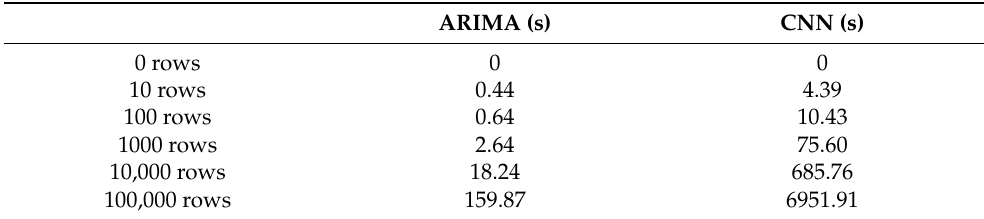
Table 8. Computational speed test results.